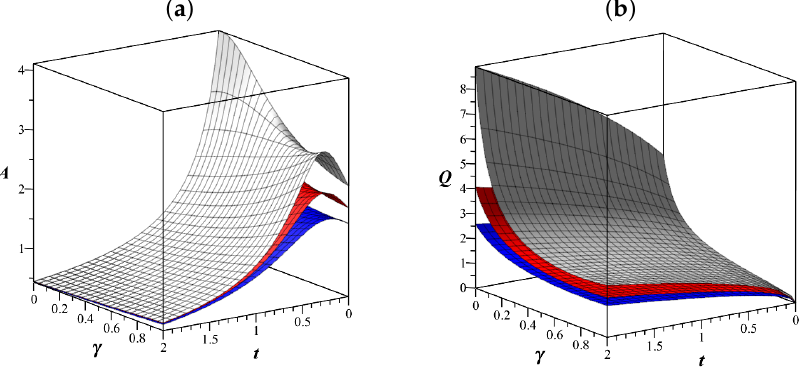
Figure 8. AFC surfaces ( a ) and Q-factor surfaces ( b ) plotted against γ and t .